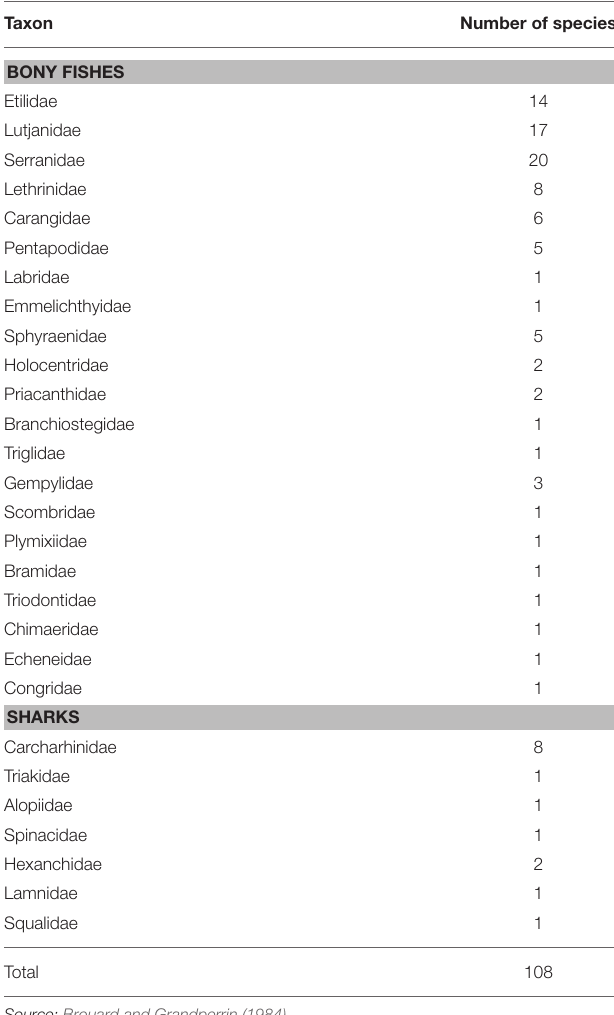
TABLE 1 | List of bycatch species of the coastal deep-bottom fisheries in Vanuatu. Taxon Number of species